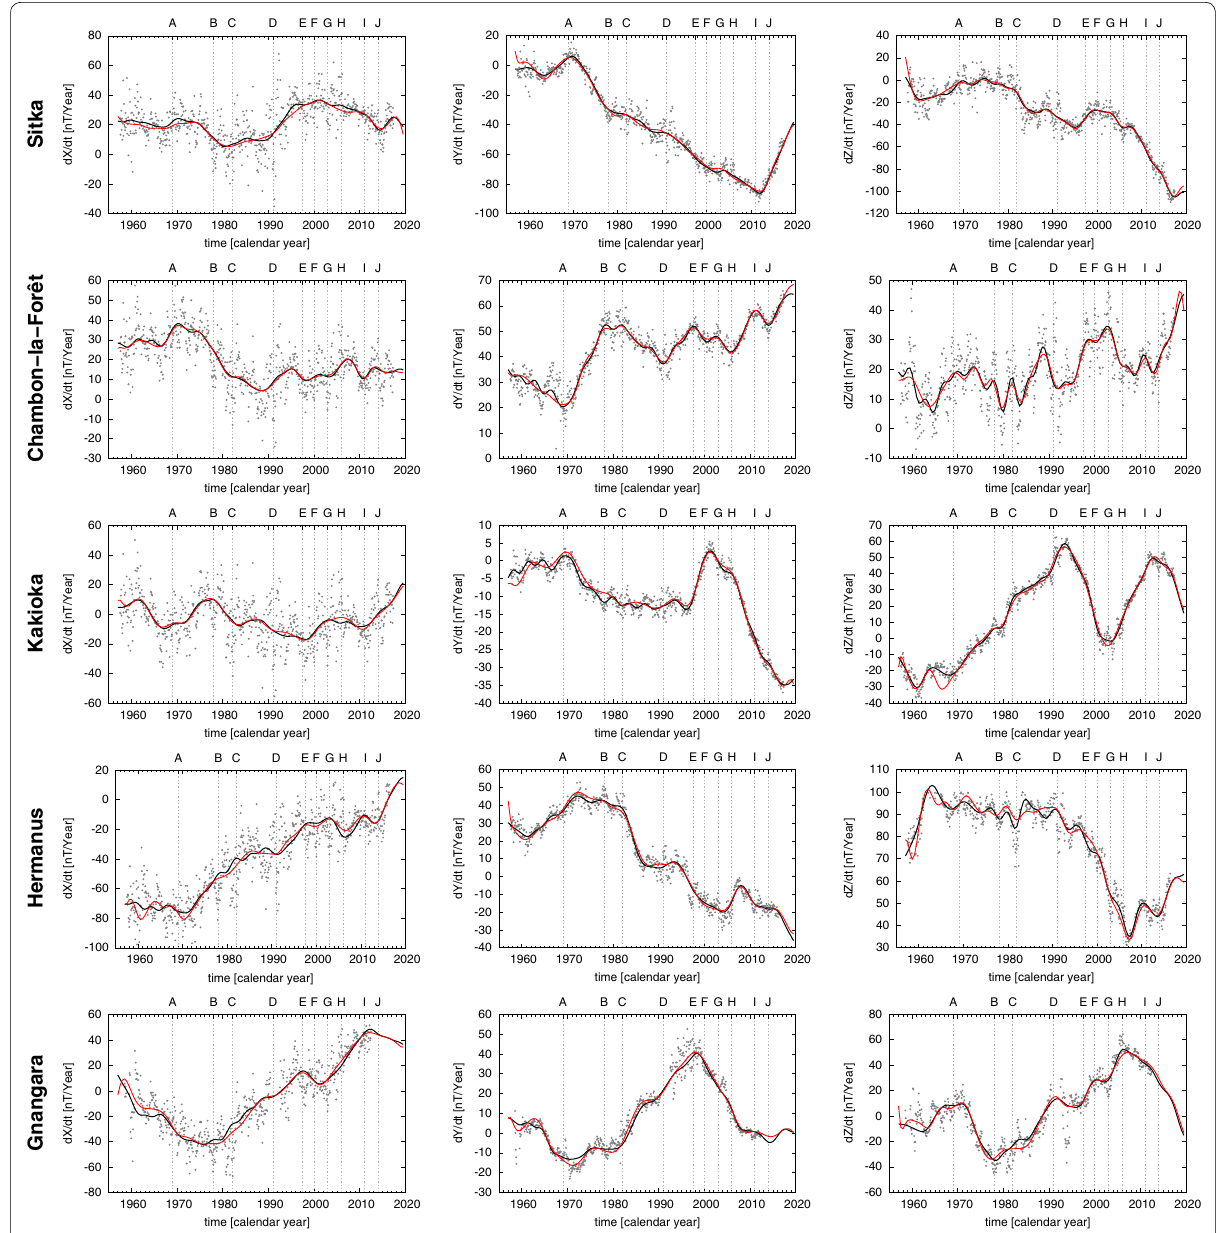
Fig. 3 Observed and modeled secular variation at some observatory sites. From top to bottom: Sitka (Alaska), Chambon-la-Forêt (France), Kakioka (Japan), Hermanus (South Africa), Gnangara (Australia). The gray dots represent the observed monthly secular variation in X, Y and Z (from left to right). Solid curves display the modeled secular variation of Model 1 (black) and Model 2 (red). Vertical lines mark occurrences of geomagnetic